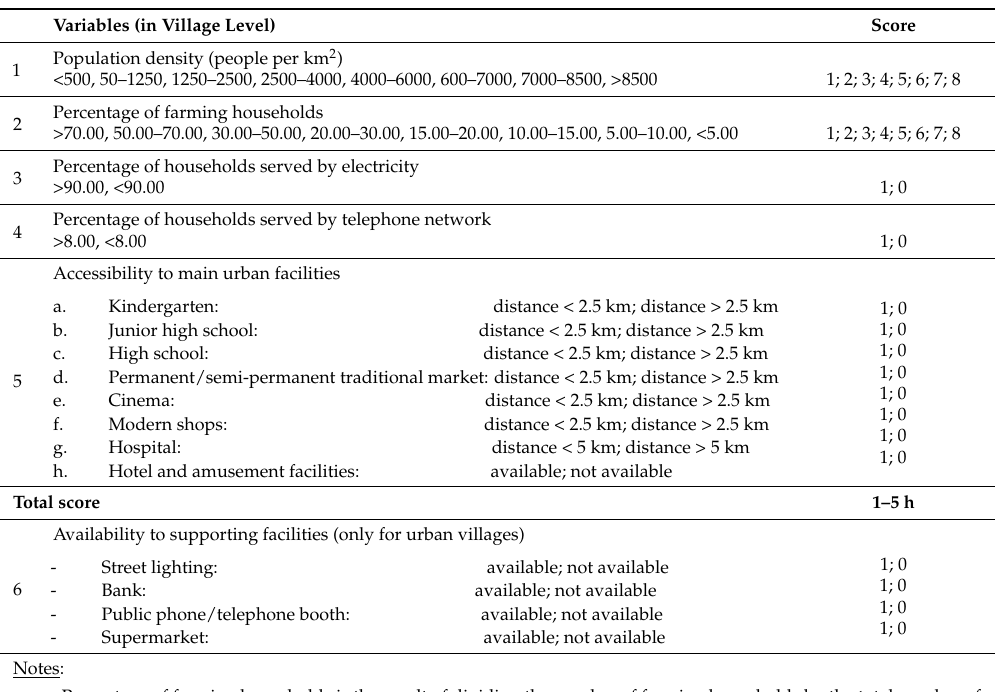
Table 2. Variables and criteria for rural–urban